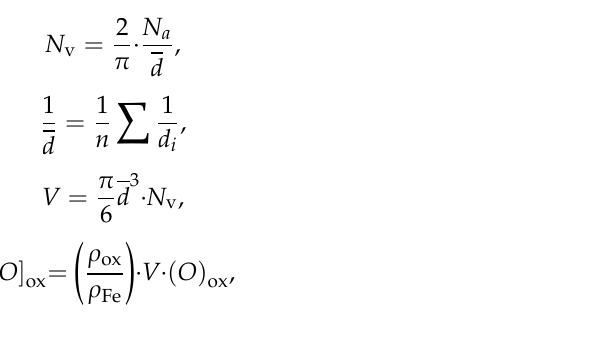
Figure 7. Accumulative density of different sizes of sulfide inclusions.